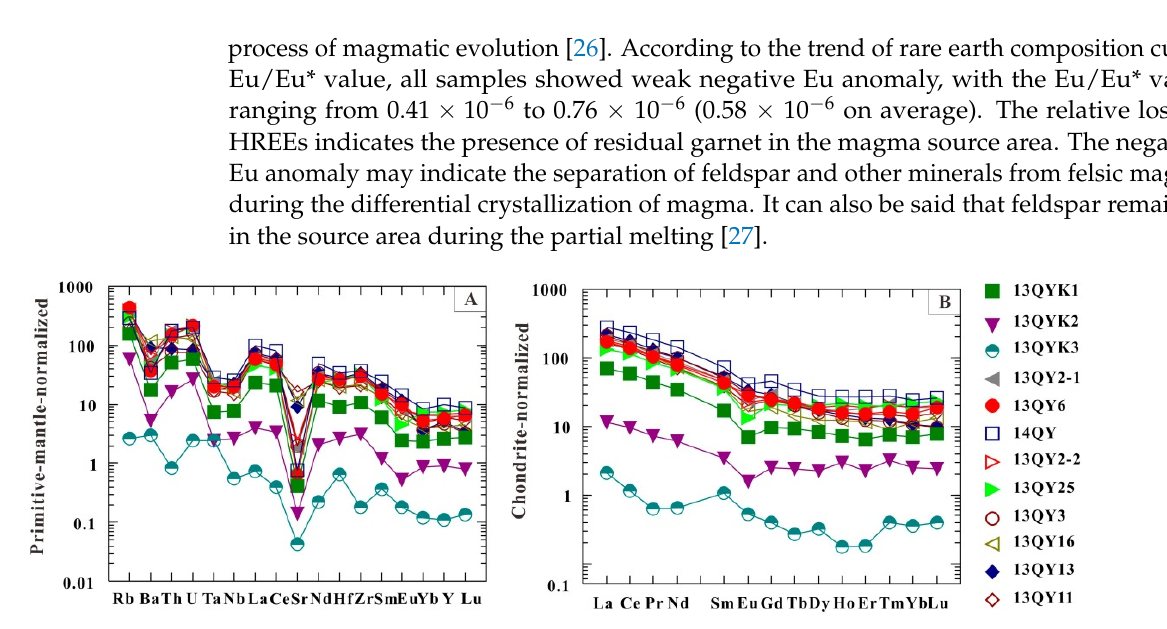
Figure 6. Primitive-mantle-normalized trace element diagrams ( A ) (normalized with data from [25]) and chondrite-normalized REE patterns ( B ) normalized with data from [25] for the representative rocks (kinds are expressed in Table 1) and ores in the Qiyimuchang deposit.